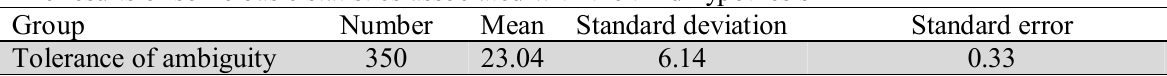
The results of some basic statistics associated with the third hypothesis